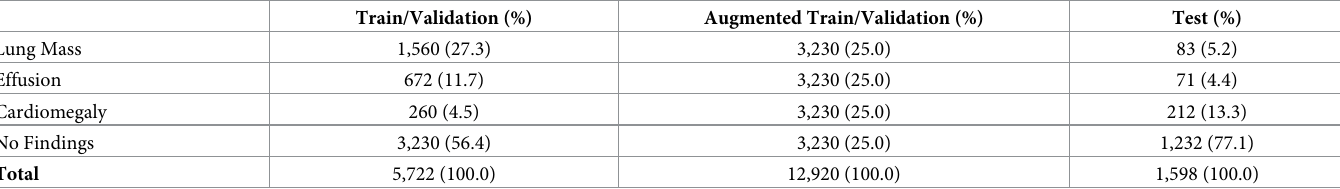
Table 3. Distribution of labels of the train/validation/test